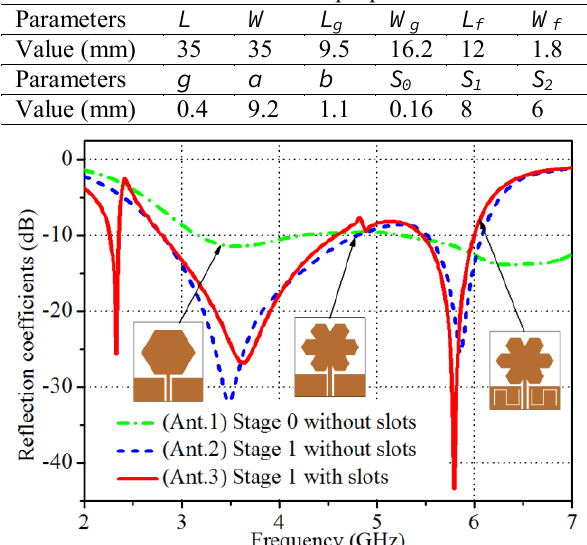
Table 1: Parameters of the proposed antenna.